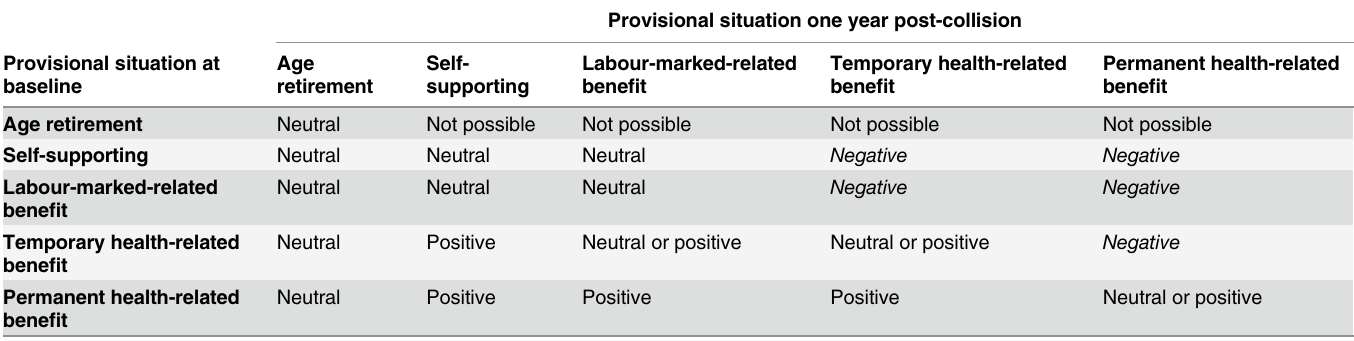
Table 3. Categorization of negative change in provisional situation from baseline to 1 year follow-up for WAD and control